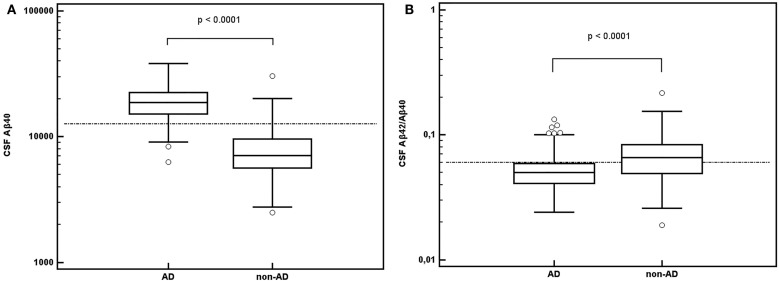
CSF Aβ42/Aβ40 ratio (A) and CSF Aβ40 concentrations in nanograms per liter (B) in AD and non-AD populations. Abbreviation: AD: Alzheimer’s disease.